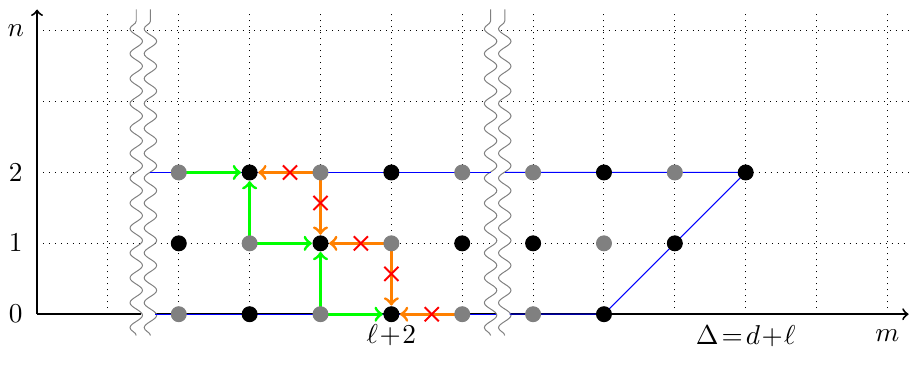
Figure 3. Vanishing k